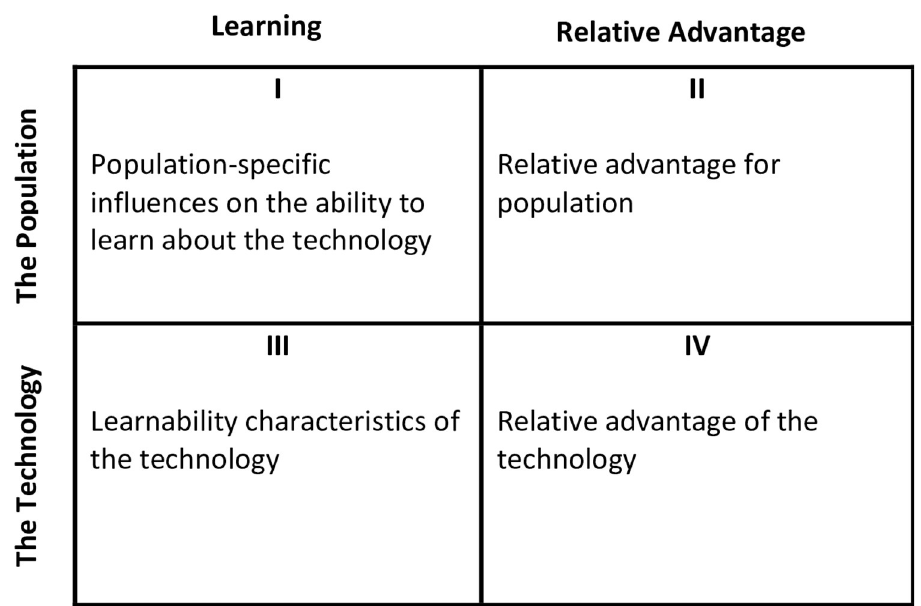
Fig 4. The four vectors of factors influencing adoption of new agricultural technologies; source [44].